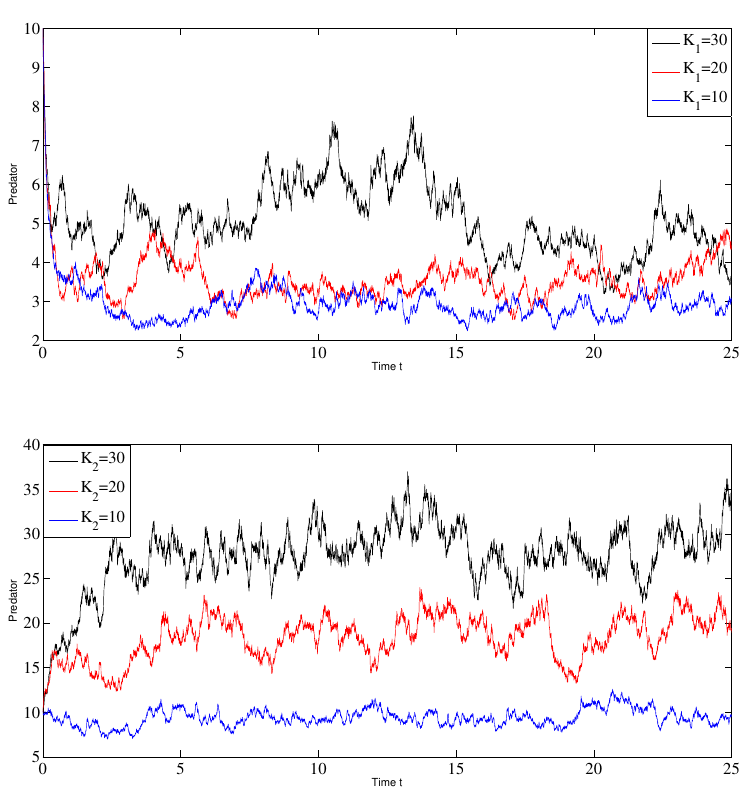
Figure 5. The behavior of the predator population for different values of K 1 and K 2